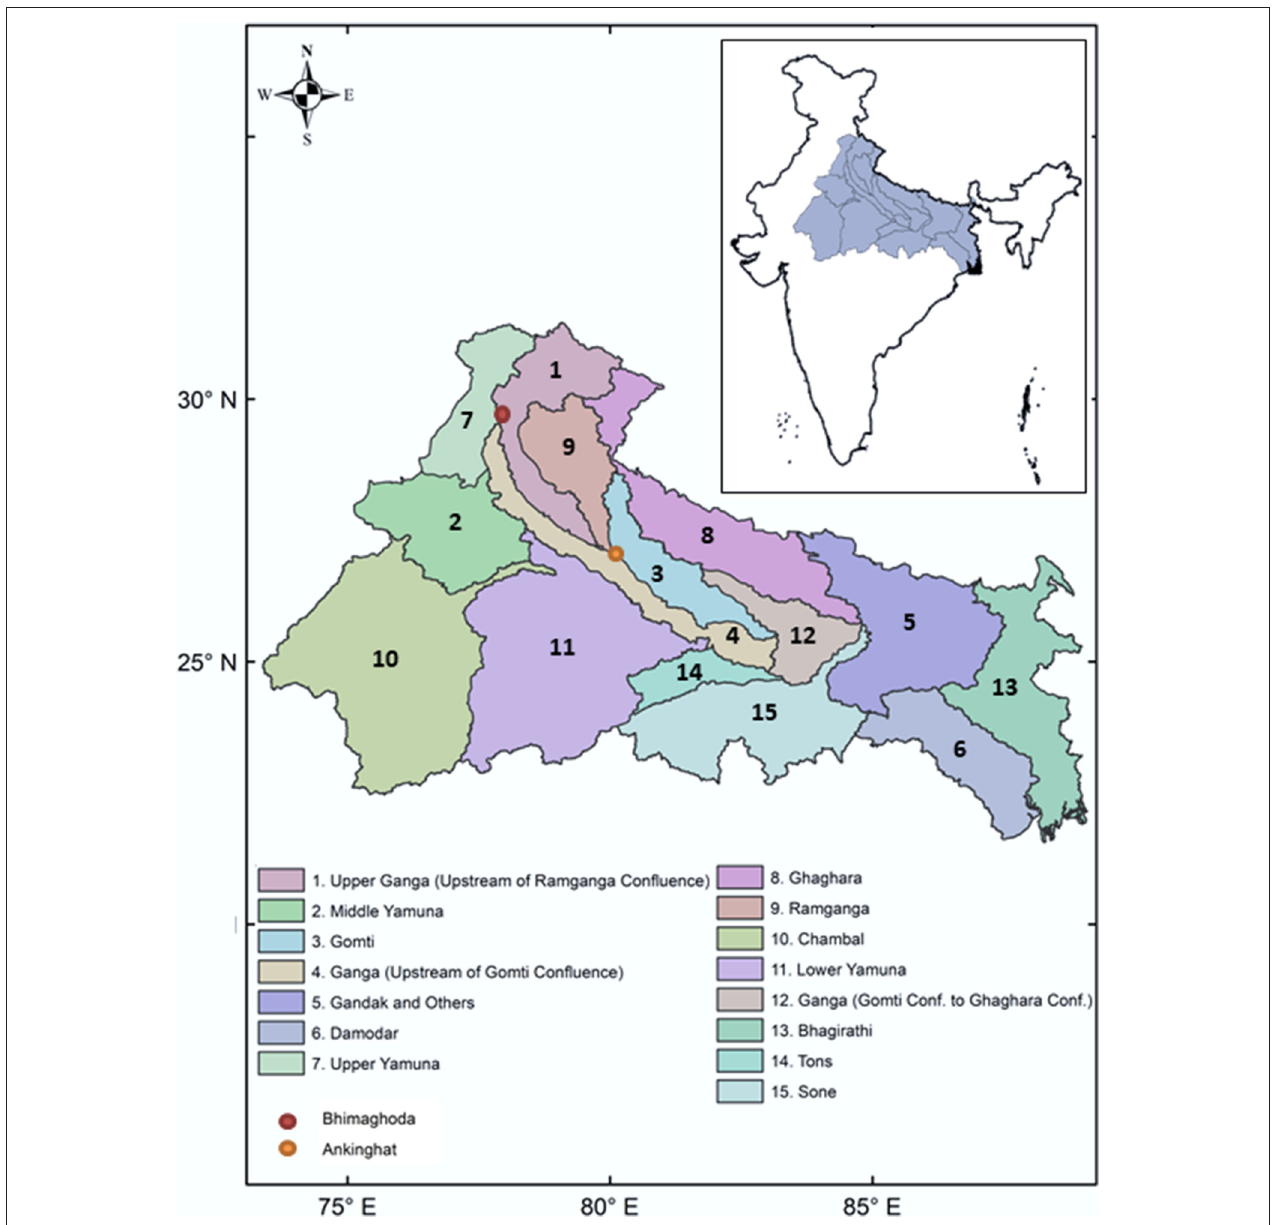
FIGURE 2 | Study area: Ganga river basin divided into 15 sub-basins. Inlet is representing location of the basin within India. Location of streamflow measurement stations, Bhimaghoda and Ankinghat are marked with dots.